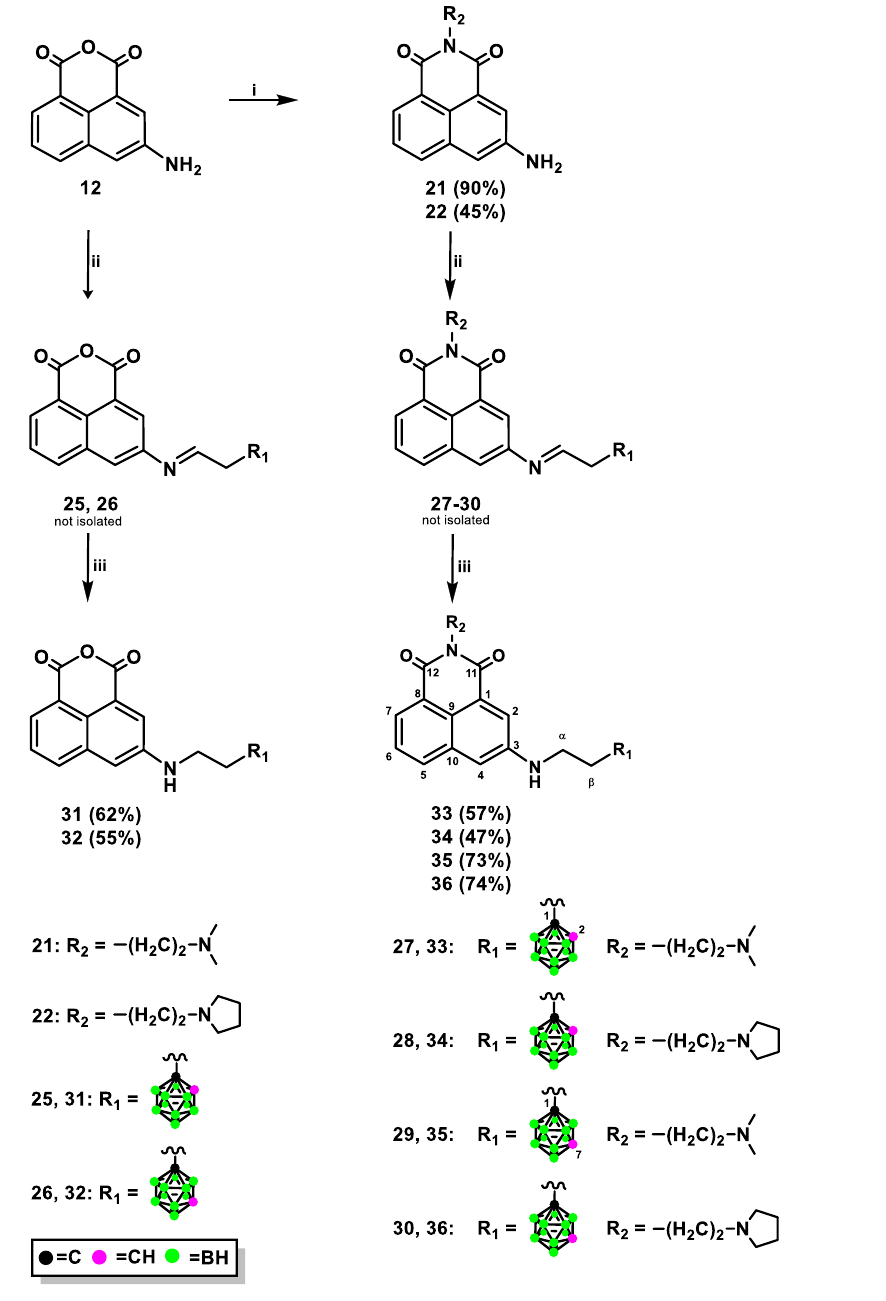
Scheme 3. Synthesis of conjugates 31 – 36 via reductive amination: Reagents and Conditions : (i) N , N -dimethylethylenedia- mine, EtOH, 1 h, 35 °C, and then 1 h, 45 °C (for 21 ); N -(2-amino- ethyl)pyrrolidine, EtOH, 1 h, 35 °C, and then 1 h, 45